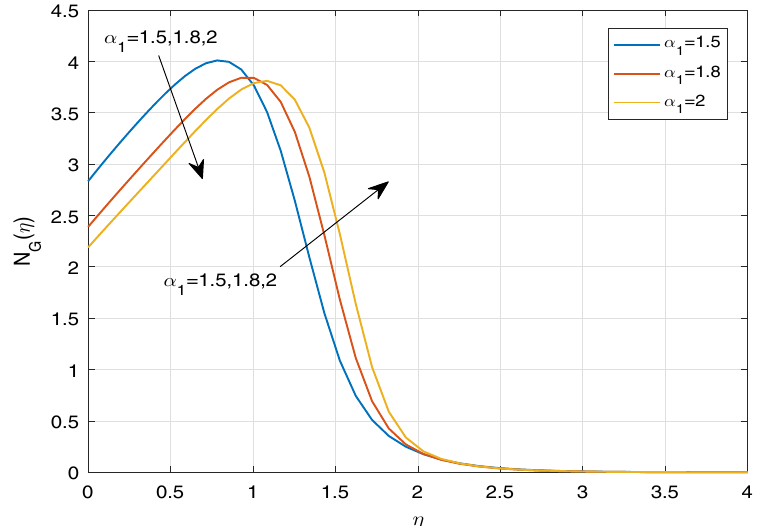
Figure 21. Sketch of N G against α 1 .